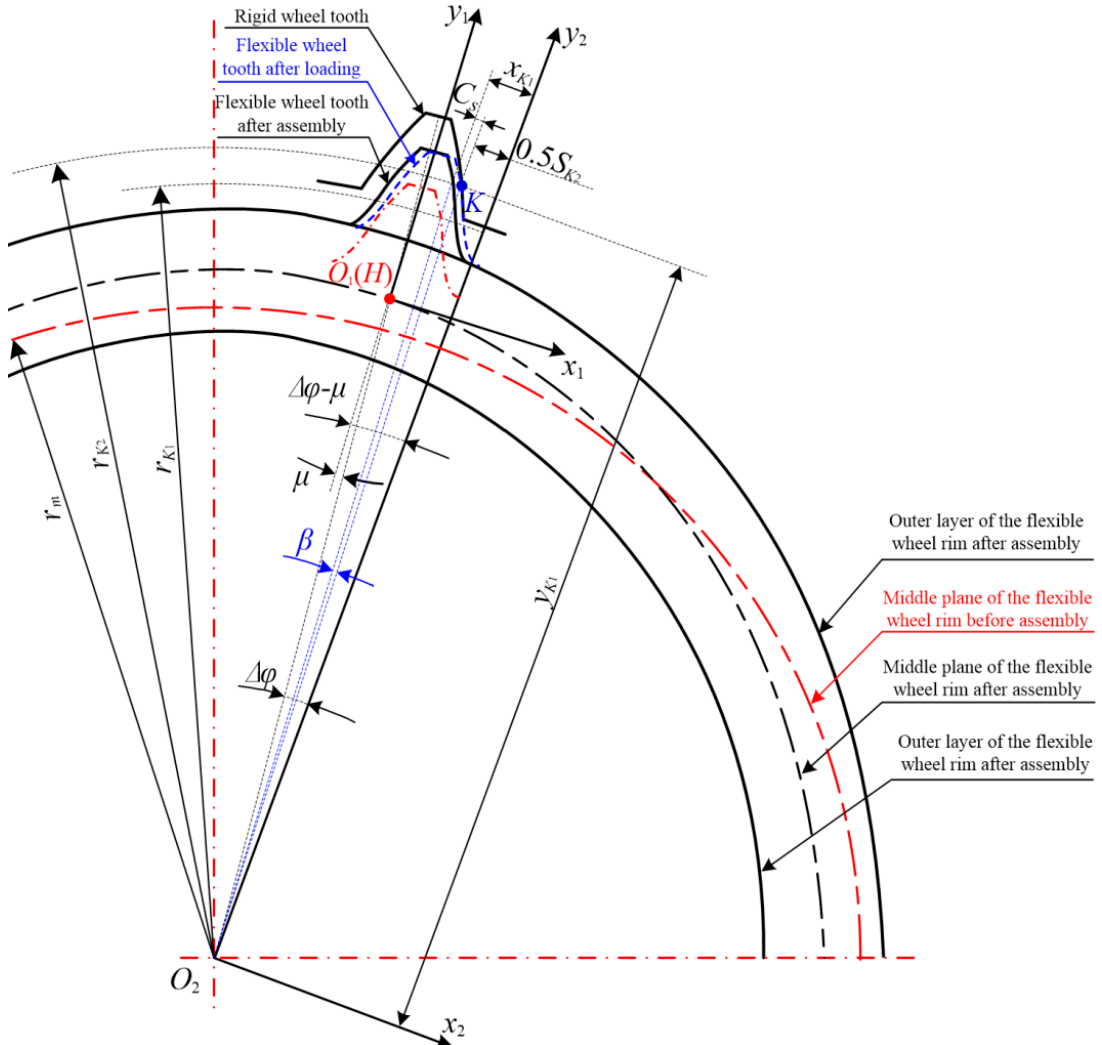
Figure 5. Engagement diagram of harmonic contact tooth pair. Two cases of flexible wheel teeth under assembly and load are included. In Figure 5, the red and black dash-dotted lines represent the middle plane of the flexible wheel rim before and after assembly, respectively. The elliptical black solid lines express the inner and outer layers of the flexible wheel rim after assembly. In addition, the red dash-dotted tooth profile curve and the black solid tooth profile curve indicate the position of the flexible wheel tooth before and after assembly, respectively. The blue dashed tooth profile curve represents the meshing position of the flexible wheel after loading. The motion trajectory of contact point K on the tooth profile of the flexible wheel relative to the tooth of the rigid wheel is given as